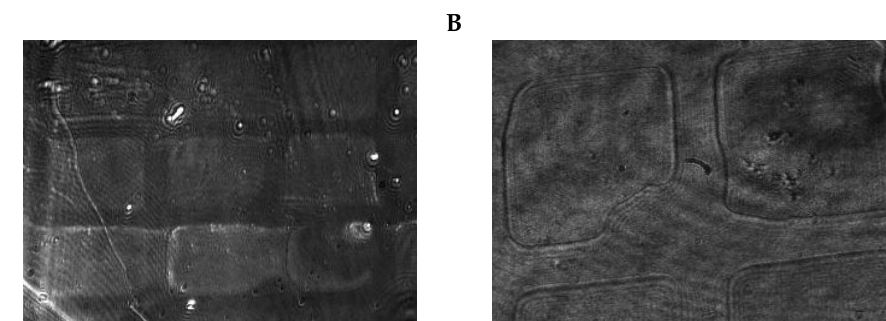
Figure 14. ( A ) the image of the nickel grid placed on a gold sensor surface of the primary-version SPR microscopy instrument, and ( B ) the image of the same grid placed on the gold sensor surface of the modified SPR microscopy instrument. Adapted from [26]. The nickel wire thickness, visible as the distance between the squares, was calibrated to 40µm.